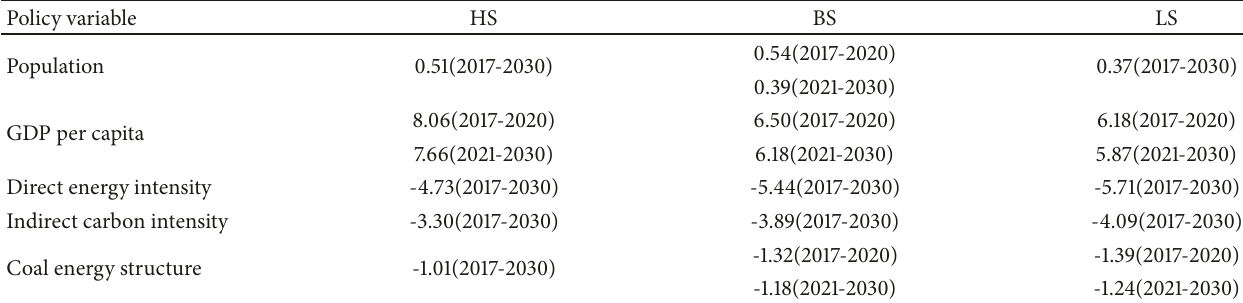
Table 9: Definition of annual variation rates of policy variables under different scenarios